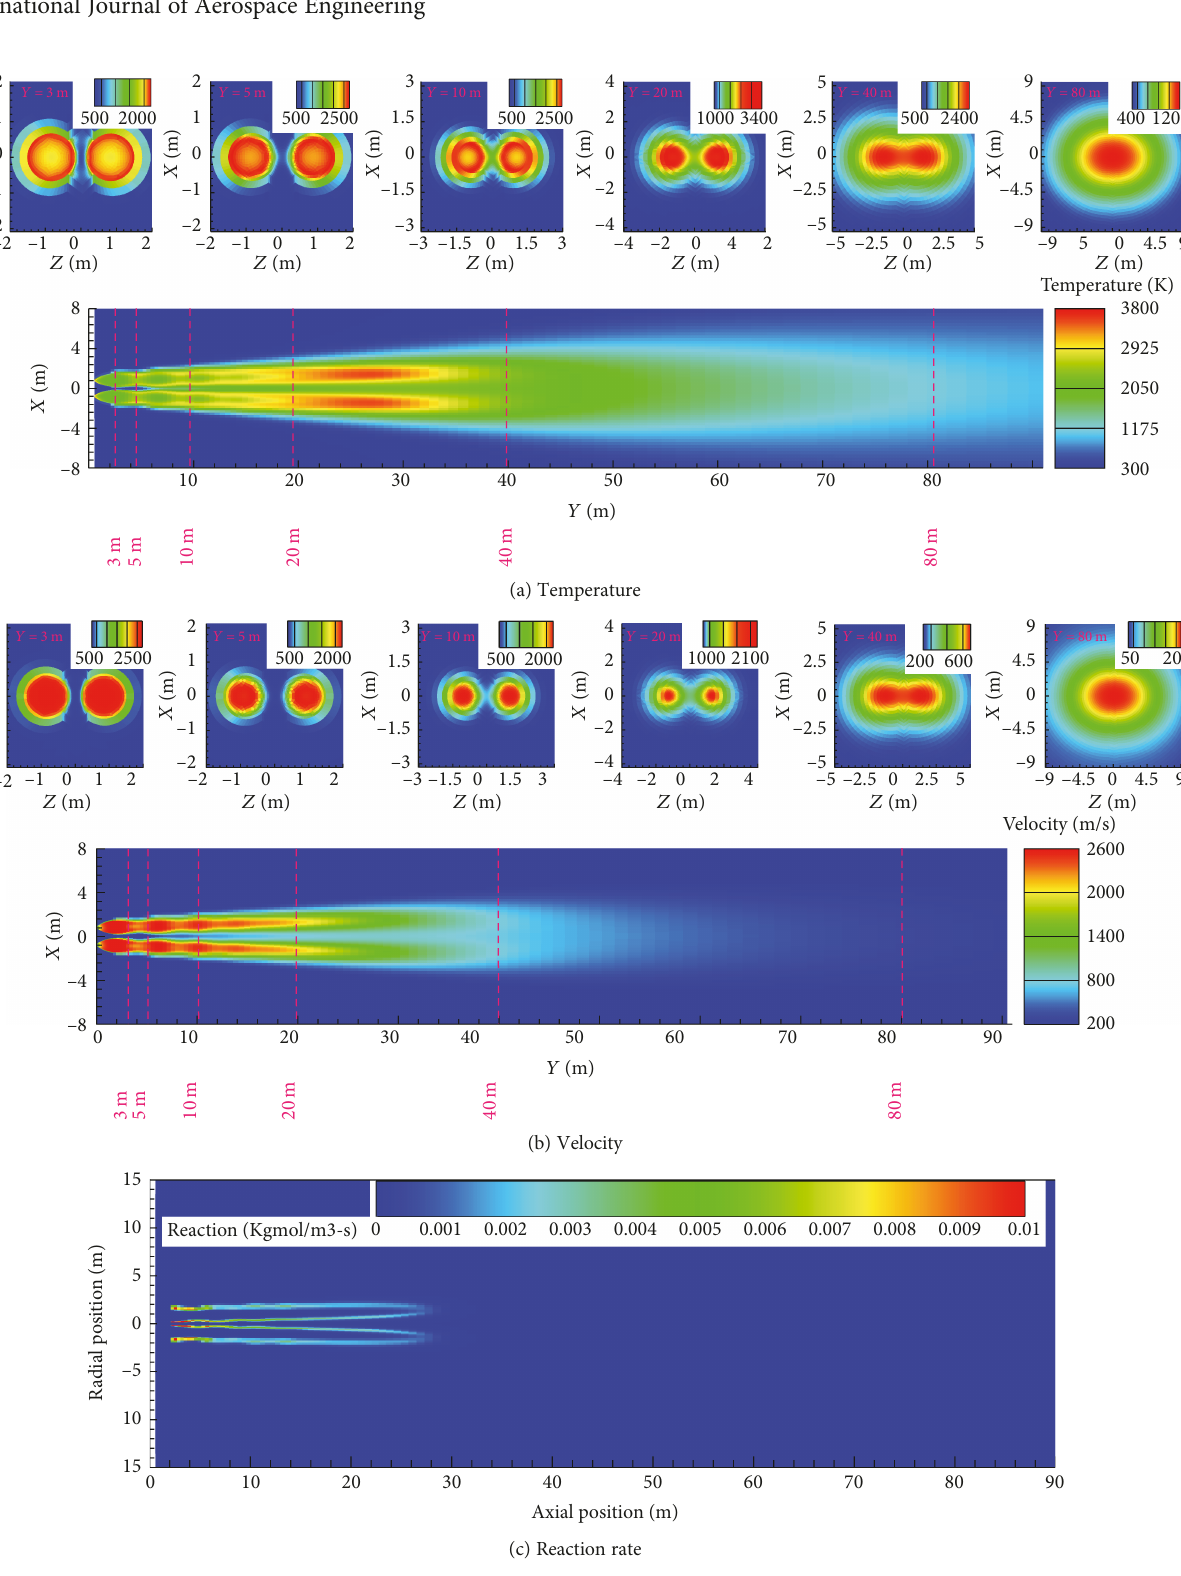
Figure 9: Plume fl ow fi elds of the double-nozzle engine (single